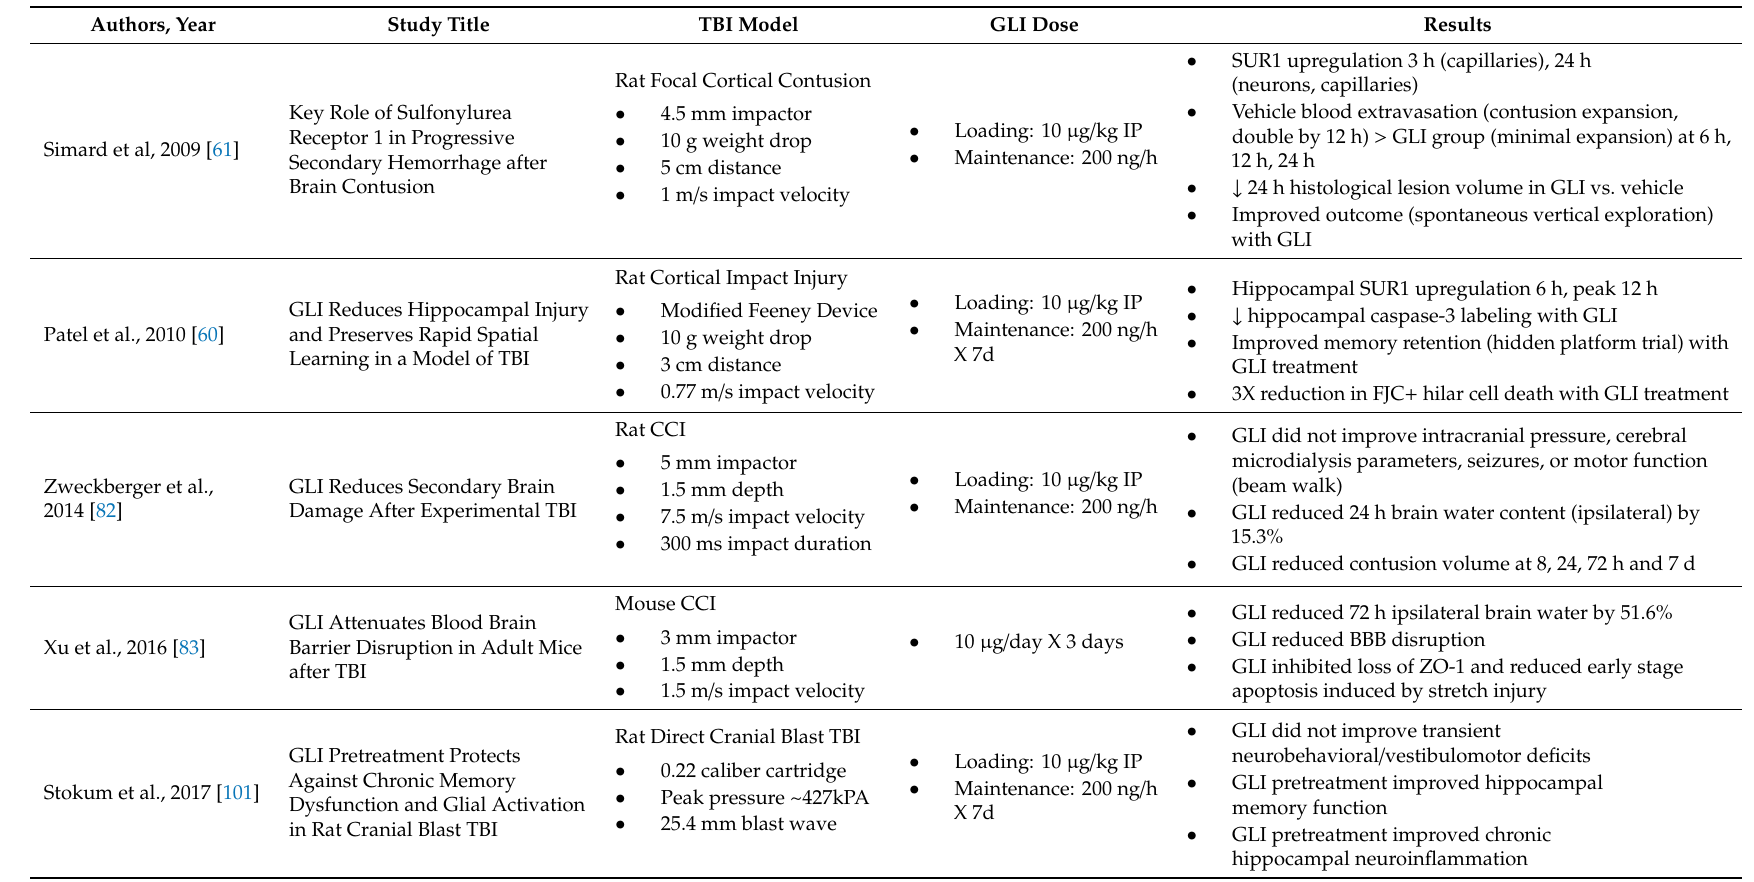
Table 2. Preclinical Studies of Glibenclamide in TBI (Chronologically